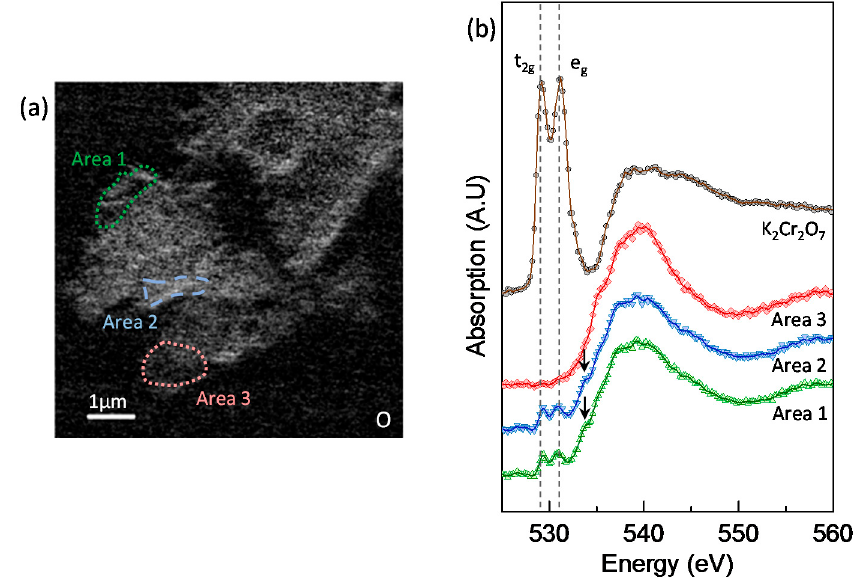
Figure 9. ( a ) Illustration of the analyzed areas in GGBS-CH-S3 for the O K -edge NEXAFS; ( b ) O K -edge NEXAFS spectra for each area in ( a ) and for K 2 Cr 2 O 7 .